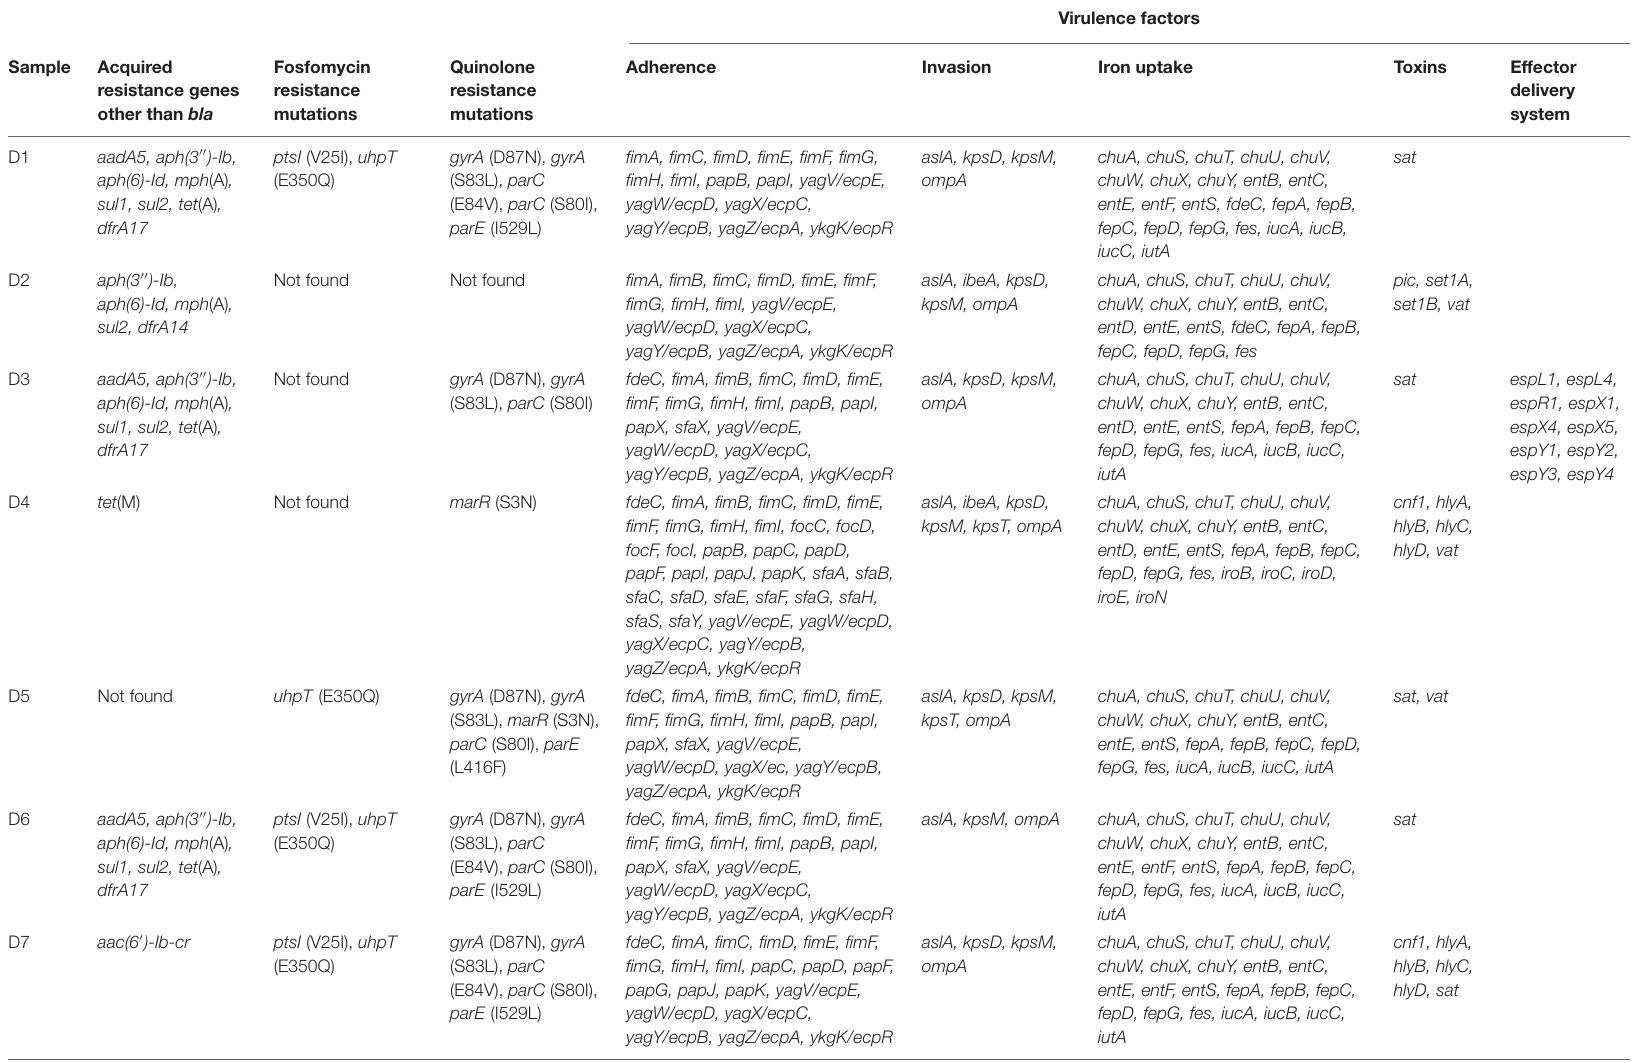
TABLE 2 | Virulence and antimicrobial resistance genes other than bla identified in 30 ESBL-producing Escherichia coli isolates obtained from Finnish patients collected in the Eastern Finland healthcare district during 2018–2020.